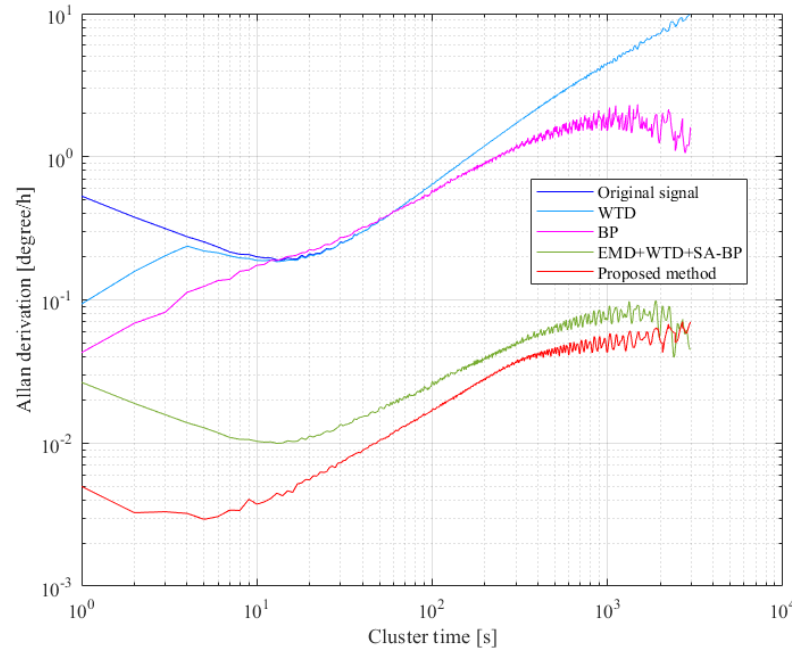
Figure 19. Allan variance analysis of the output signals before and after processing.